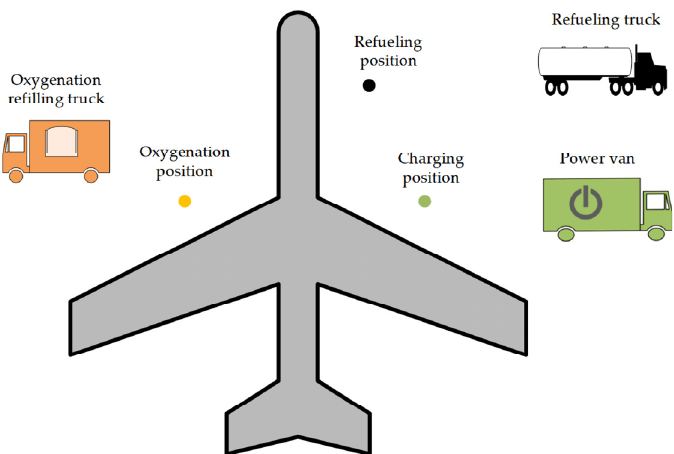
Figure 3. Operation location of each support vehicles.